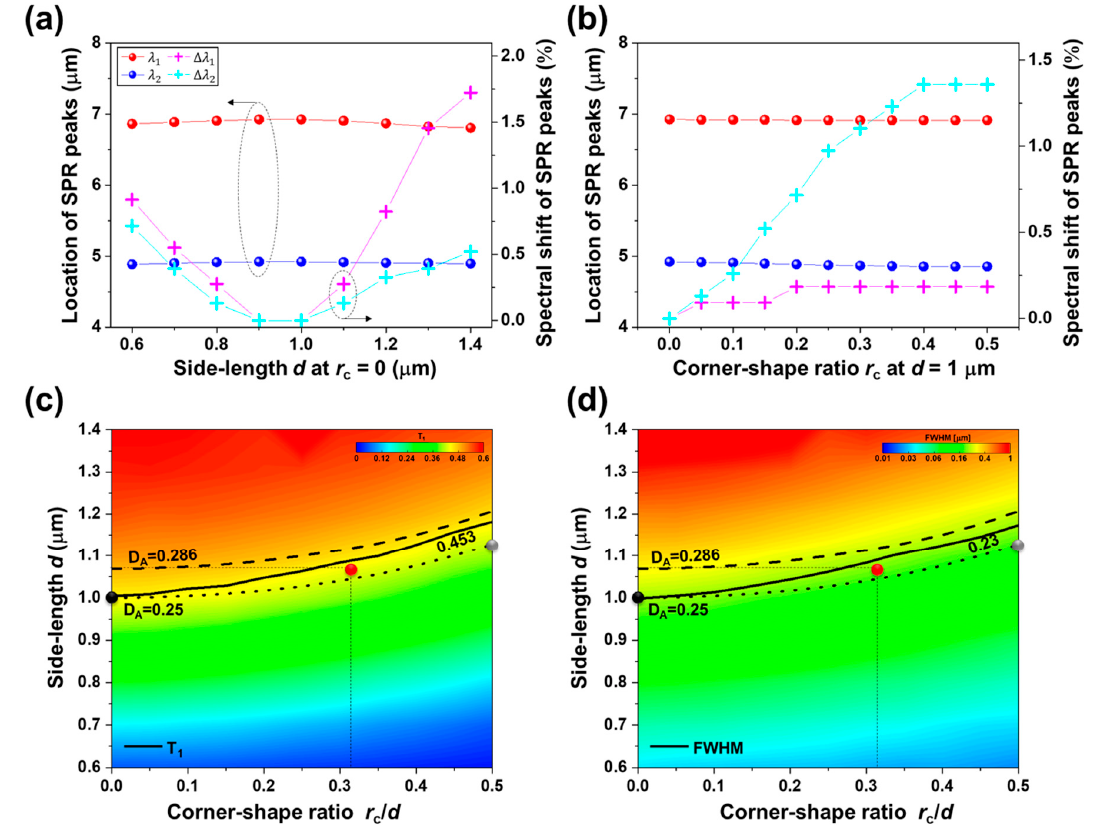
Figure 3. The location and spectral shift of peak transmission at the first- and second-order SPR modes for MHA/GaAs structure as a function of ( a ) the side length d with a fixed r c at 0; ( b ) the ratio of corner-shape radius to the side length, r c / d with d = 1 µ m. The first- and second-order SPR peak wavelengths ( λ 1 and λ 2 ) and the spectral shift of SPR-transmission peaks ( ∆ λ 1 and ∆ λ 2 ) are represented by the red, blue, magenta, and cyan symbols, respectively. The colormaps of ( c ) transmission peak intensity; ( d ) the bandwidth at 50% of the peak transmission (FWHM) at λ 1 = 6.93 µ m as a function of d (0.6 µ m ≤ d ≤ 1.4 µ m) and r c / d (0 ≤ r c ⁄ d ≤ 0.5).